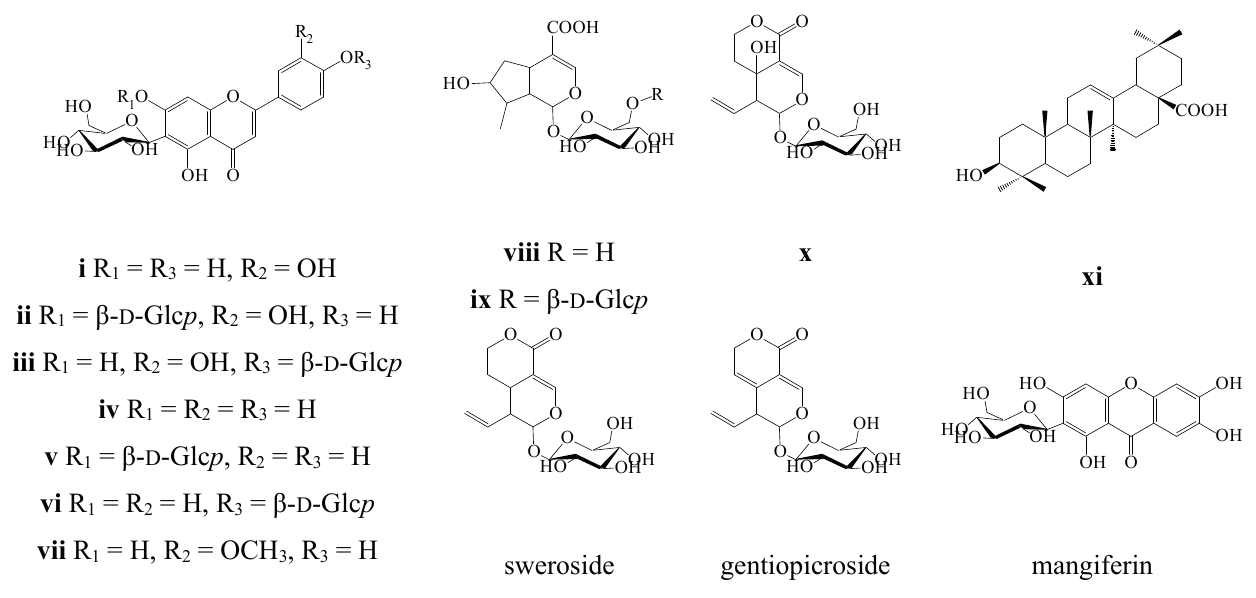
Figure 2. Phytochemicals, detected in four gentian